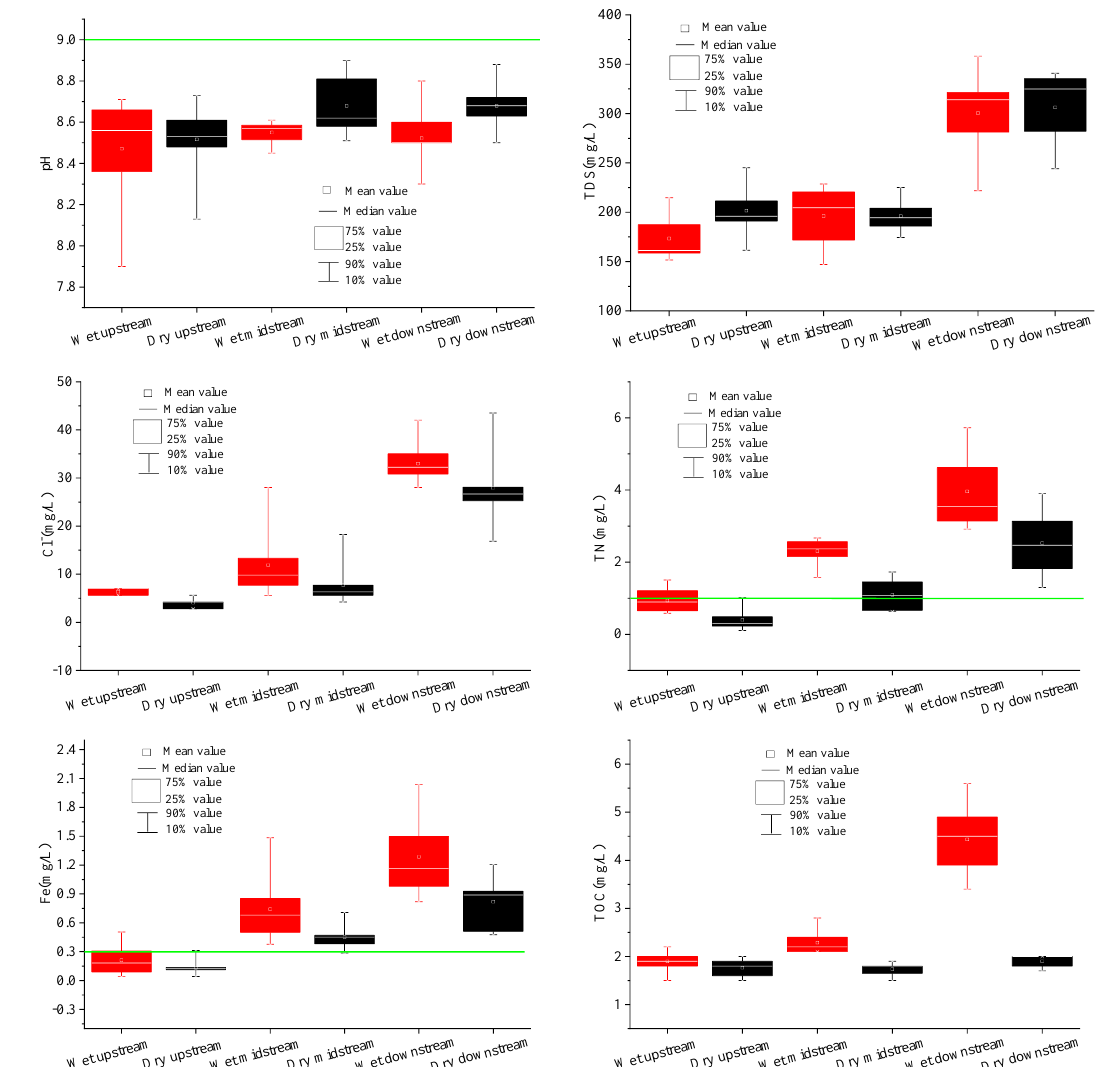
Figure 2. Temporal variations in six water parameters in the Beichuan River.